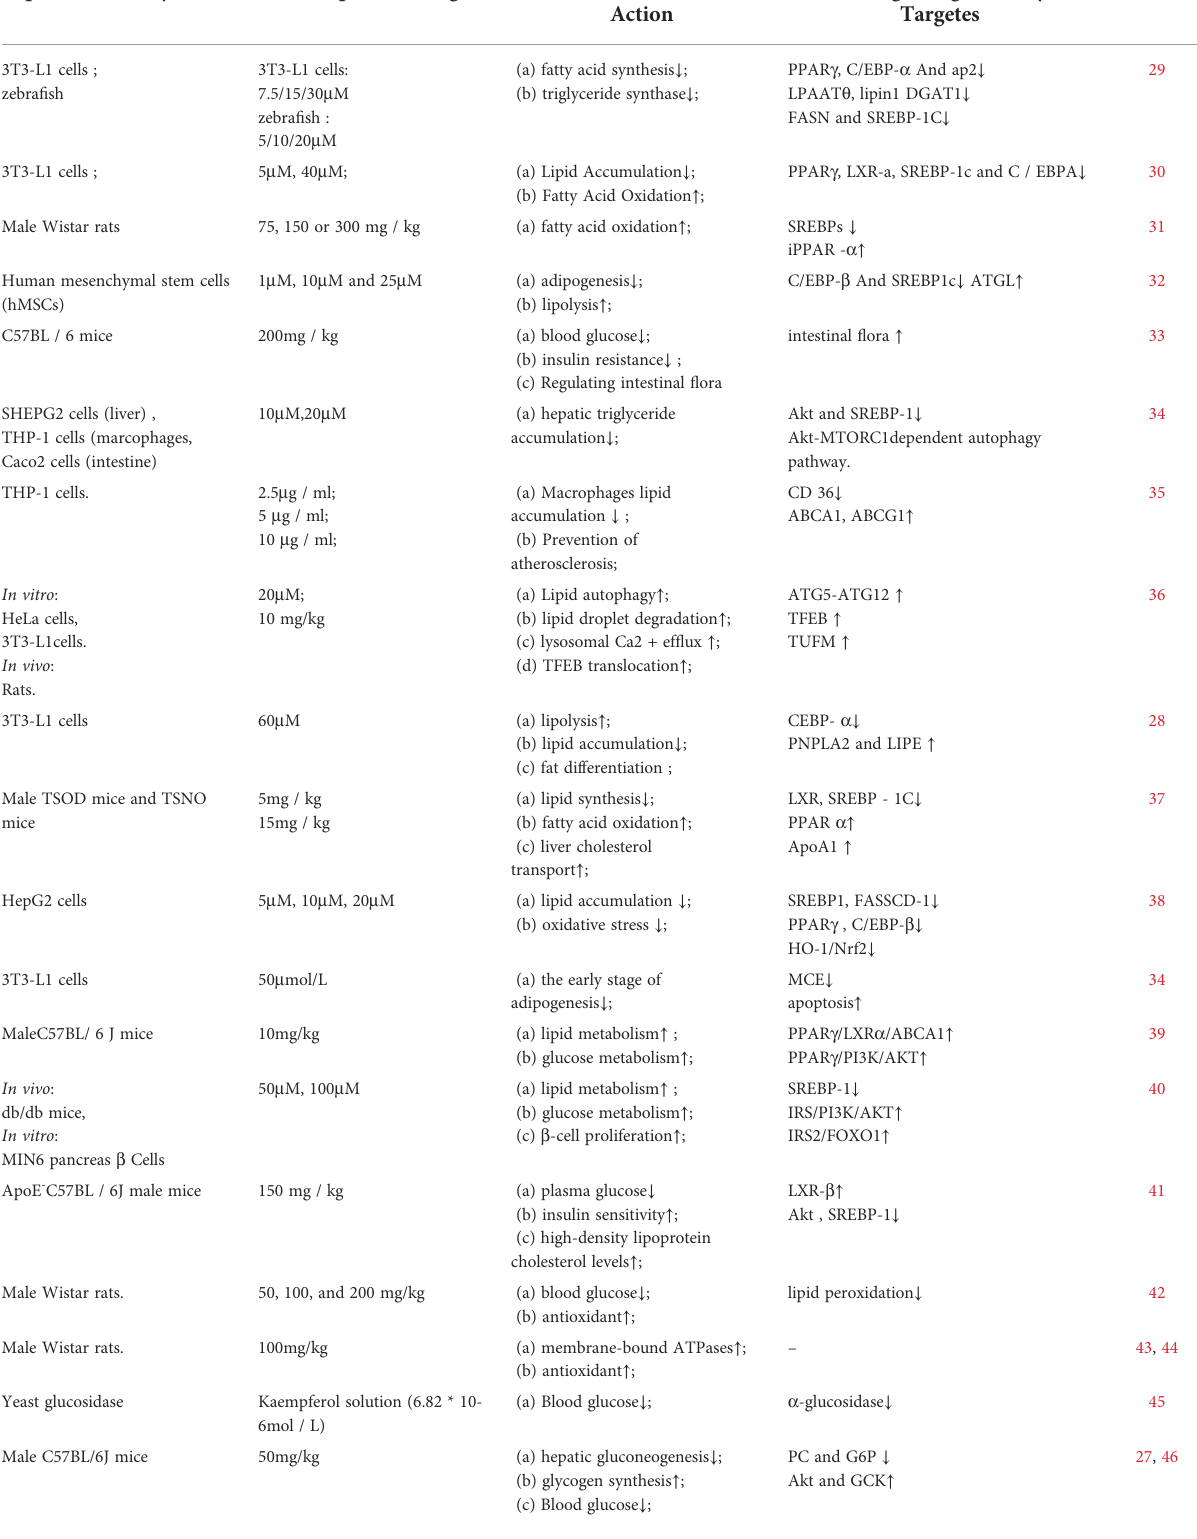
TABLE 1 Mechanism of kaempferol